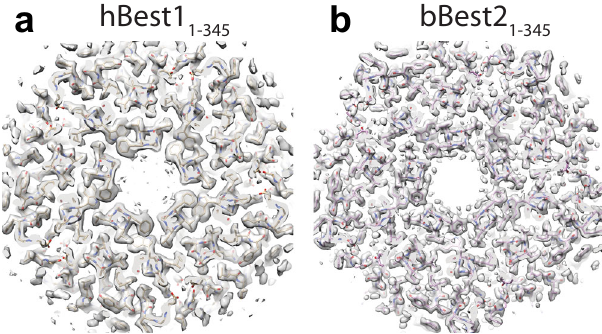
Fig. 4 Structures of AS truncated mutants. a , b Top view of cryo- EM map and model showing fully open necks of hBest1 1-345 a and bBest2 1 – 345 b